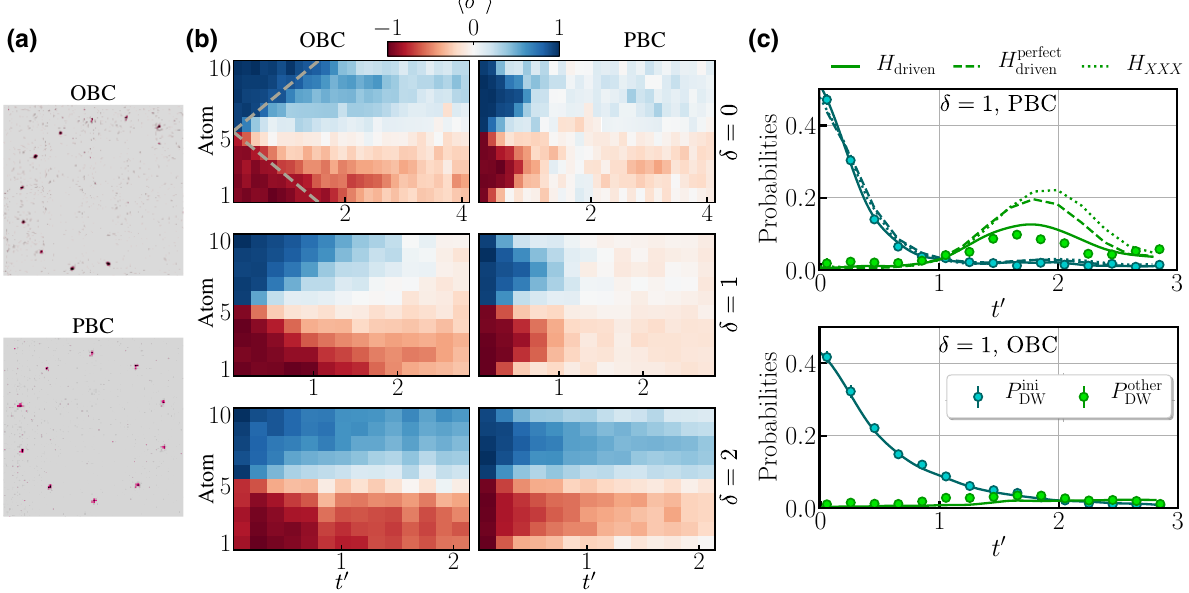
FIG. 3. The dynamics of domain-wall states under H XXZ in 1D systems. (a) Fluorescence images of the trapped atoms for the two geometries used in the experiment: the spiral implements open boundary conditions (OBCs), while the circle realizes periodic boundary conditions (PBCs). (b) Density maps of the temporal evolution of the z magnetization (cid:6) σ z time t (cid:12) , following the preparation of a domain-wall state, for anisotropies δ = 0, 1, and 2 and OBC (left) and PBC (right) geometries. The dashed gray line shows the light cone ξ = ± 2 Jt (cid:12) . (c) The evolution of the probability of occurrence of domain walls for OBCs and PBCs. The solid lines are the simulations using H driven accounting for all experimental imperfections (SPAM errors, shot-to-shot fluctuations in atomic positions, and microwave imperfections). The dashed (dotted) line is a simulation using H perfect microwave